Question: Based on the figure, does the quantity rise or fall?
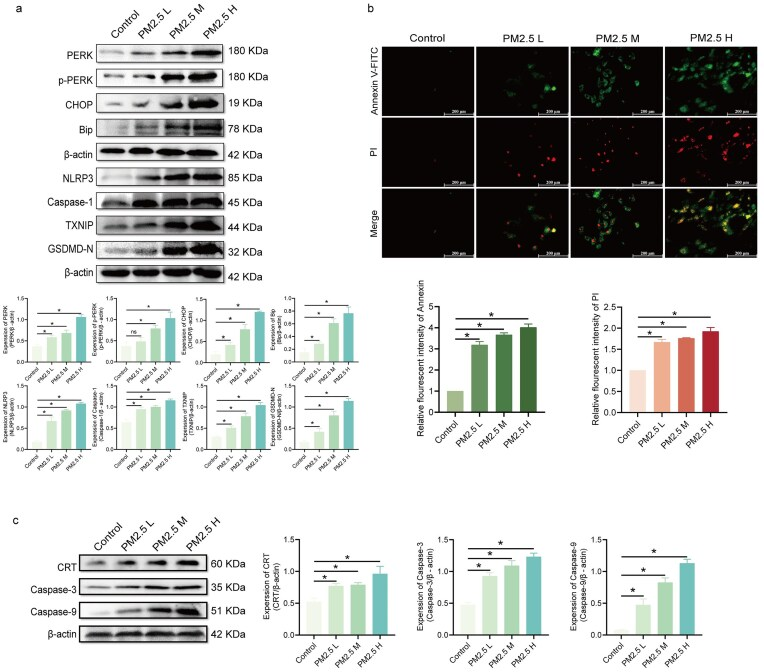
Answer: increasing